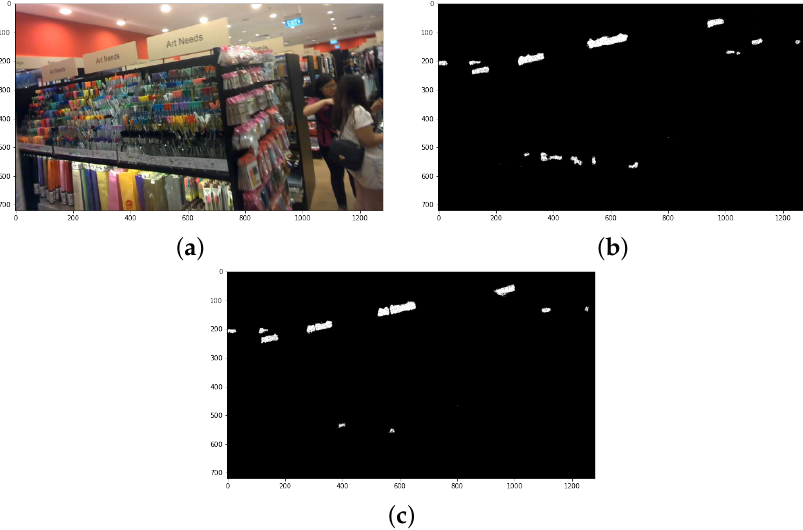
Figure 6. Filtered text confidence score maps for the example in ( a ): the score map with Text Attention 1 block shown in ( b ), and with Text Attention 1, 2 and 3 blocks shown in ( c